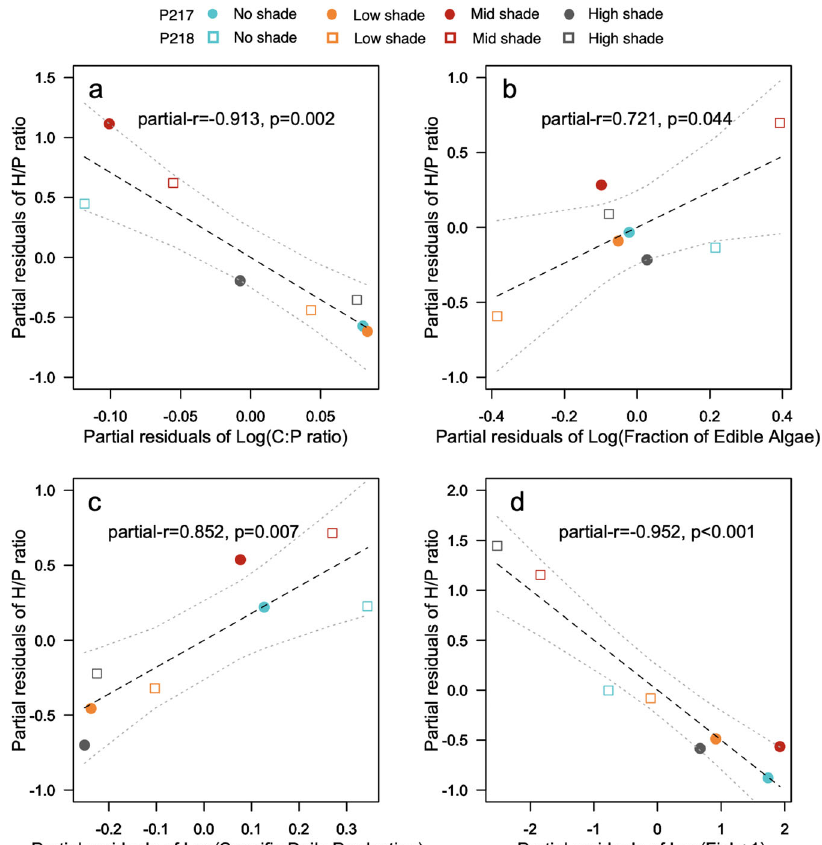
Fig. 4 Partial effects of edible phytoplankton fraction, seston C:P ratio, speci fi c production rate, and fi sh abundance on H/P mass ratio. Partial regression leverage plots showing relationships between H/P mass ratio (the response variables), and log-transformed C:P ratio of seston ( a ), fraction of edible algae ( b ), speci fi c daily production ( c ), and relative fi sh abundance ( d ) (the explanatory variables) without interfering effects from other explanatory variables. The vertical axis represents the partial residuals of H/P mass ratio, and the horizontal axis represents the partial residual of the speci fi c explanatory variable. Dashed and dotted lines in each panel represent the partial regression line and its 95% con fi dence curves. Partial correlation coef fi cients with p values are also inserted in each panel. Data from four different treatments of pond 217 (circles) and 218 (squares) are denoted by different